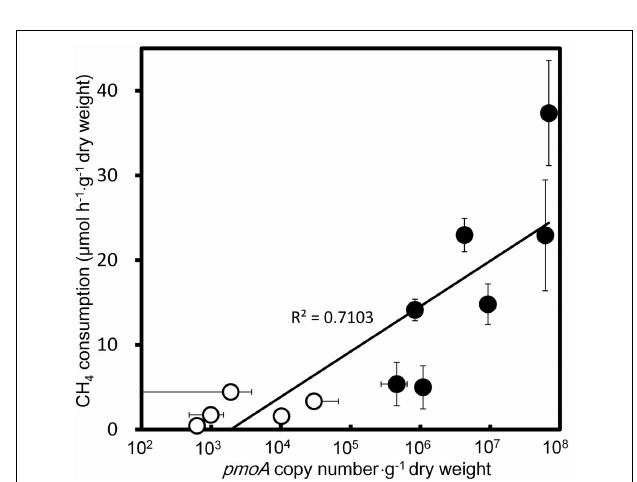
shows the incubated E. densa (left) and lake water (right) in bottles. N and W indicate unwashed native samples and samples washed by shaking three times in lake water, respectively. “n.t.” is “not determined.”